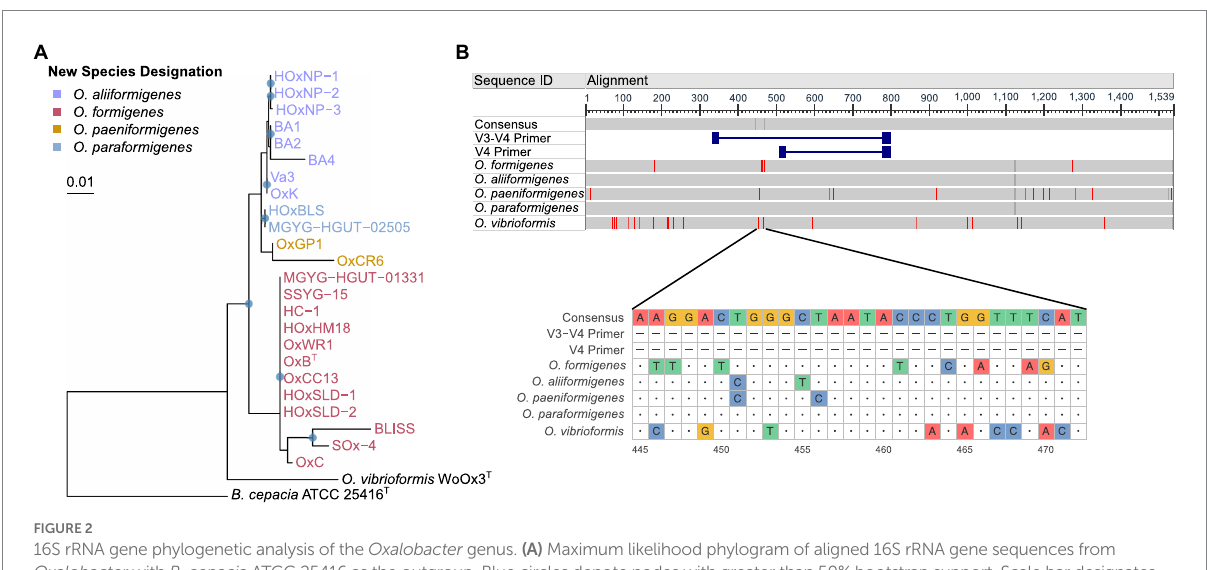
FIGURE 2 16S rRNA gene phylogenetic analysis of the Oxalobacter genus. (A) Maximum likelihood phylogram of aligned 16S rRNA gene sequences from Oxalobacter with B. cepacia ATCC 25416 as the outgroup. Blue circles denote nodes with greater than 50% bootstrap support. Scale bar designates mean number of nucleic acid substitutions per site. (B) Alignment of consensus 16S rRNA gene sequences from each species of Oxalobacter . Red regions indicate nucleotides different than the than the consensus sequence, which excludes the V3-V4 and V4 primers. Dark gray regions show gaps in the gene. Light gray regions show similarity. Below is a nucleotide level view of the 445–472 bp region of the 16S rRNA gene.